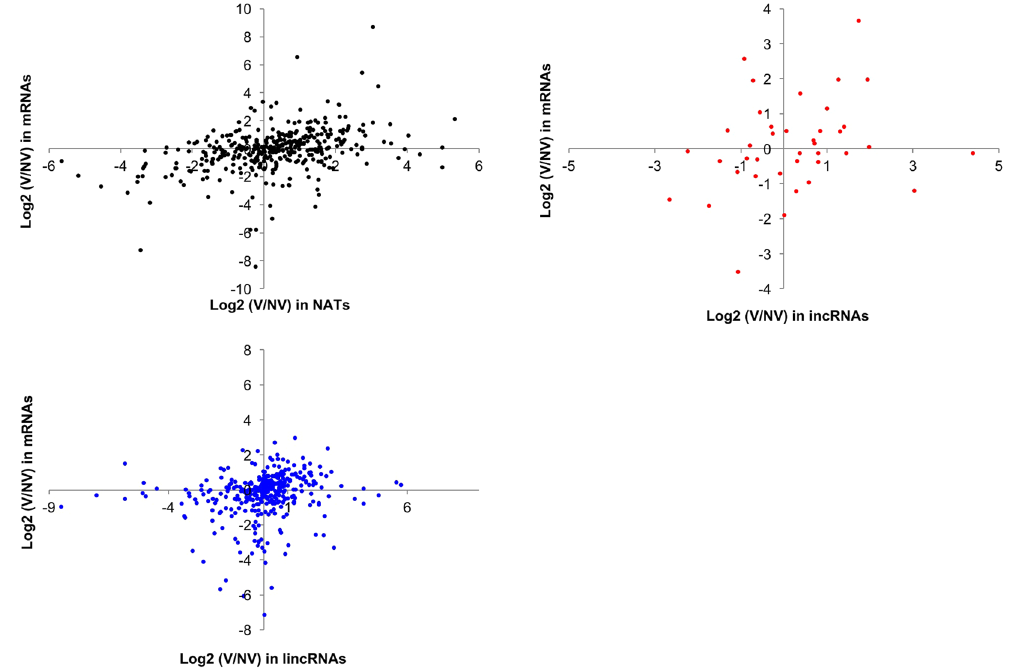
Figure 4. Box plot representing the change of expression levels of lncRNAs and their paired mRNAs by four weeks of cold treatment. In the case of lincRNAs, the genes within 2 kb from lincRNAs were used for comparison. V, with four weeks of cold treatment; NV, without cold